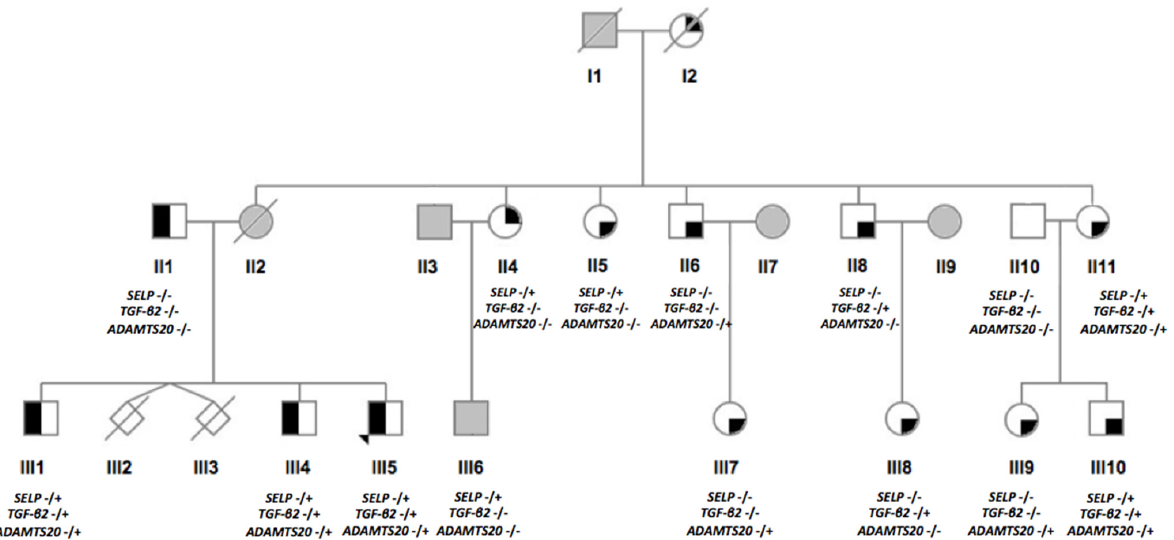
Figure 2. Segregation of the three risk variants confirmed by Sanger sequencing in recruited relatives. The gene name represents the respective gene variants (i.e., SELP c.2177T>C, TGF- β 2 c.1136C>T and ADAMTS20 c.4090A>T). The gene name (in italics) is followed by the genotype, with ‘-/-‘ representing a homozygous reference genotype, whereas ‘-/+‘ represents a heterozygous genotype for each respective variant.